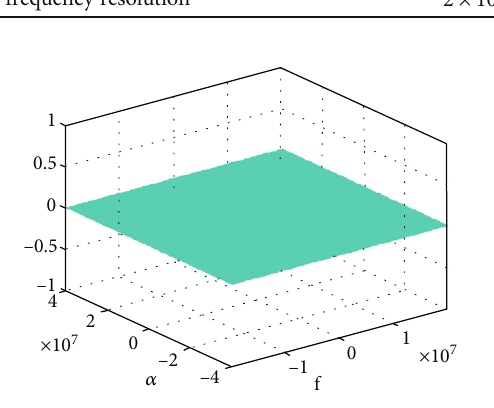
Figure 2: Cycle spectrum H